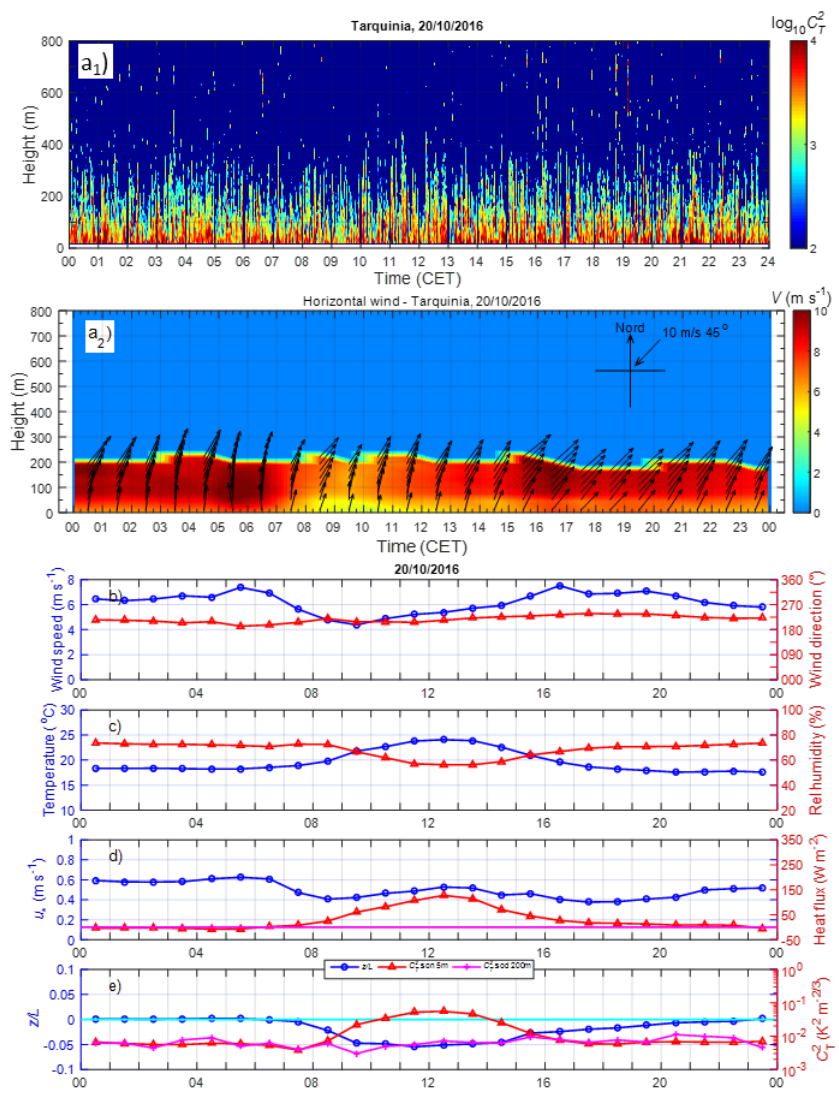
Figure 17. Example of the diurnal variation of the ( a 1 ) ABL thermal turbulence and ( a 2 ) wind field structures; ( b ) wind speed and direction at 5 m; ( c ) temperature and relative humidity; ( d ) friction velocity and sensible heat flux; and ( e ) the stability parameter z / L at 5 m and the temperature structure parameter C T 2 at 5 m (from the sonic anemometer) and at 200 m (from the sodar in arbitrary units) on 20 October 2016.